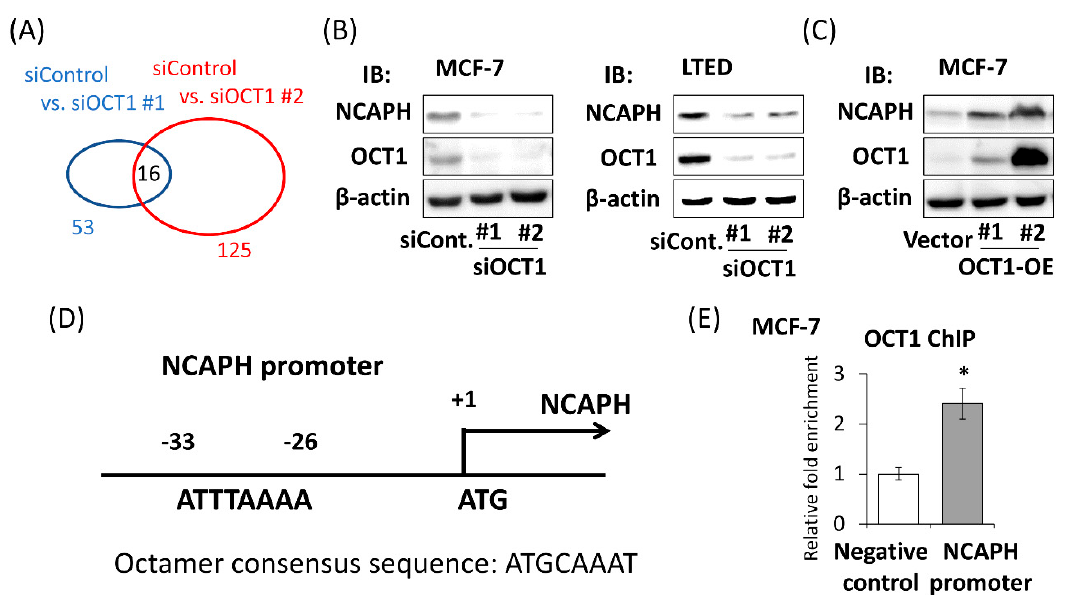
Figure 2. NCAPH was one of the OCT1-regulated genes in MCF-7 cells. ( A ) The results of microarray analyses were summarized. Genes downregulated with a fold change ≥ 8 by silencing OCT1 with siOCT1 #1 (blue oval) or with siOCT1 #2 (red oval) compared to treatment with siControl are shown. The digits indicate the number of genes. Sixteen genes were downregulated in common. ( B ) Western blot analysis for NCAPH and OCT1 expressions in MCF-7 cells and LTED cells treated with two kinds of siRNAs for OCT1 (siOCT1 #1 or #2) or siControl (siCont.). β -actin protein was blotted as a loading control. IB, immunoblot. ( C ) Western blot analysis for NCAPH and OCT1 expressions in two clones of MCF-7 cells stably expressing OCT1 (OCT1-OE #1 and #2) and an MCF-7 clone transfected with empty vector (Vector). β -actin protein was blotted as a loading control. ( D ) Schema of NCAPH promoter region. A putative octamer consensus sequence (ATTTAAAA) exists at 26 base pairs upstream from the translation initiation site (ATG) of NCAPH gene. ( E ) Association of OCT1 in the promoter region of NCAPH in MCF-7 cells. ChIP assay for OCT1 or normal rabbit IgG was performed. The fold enrichments relative to IgG in NCAPH promoter and another locus in NCAPH (negative control) were measured by performing quantitative PCR (qPCR). Relative fold enrichment was shown as mean and SEM ( n = 3). * p < 0.05.